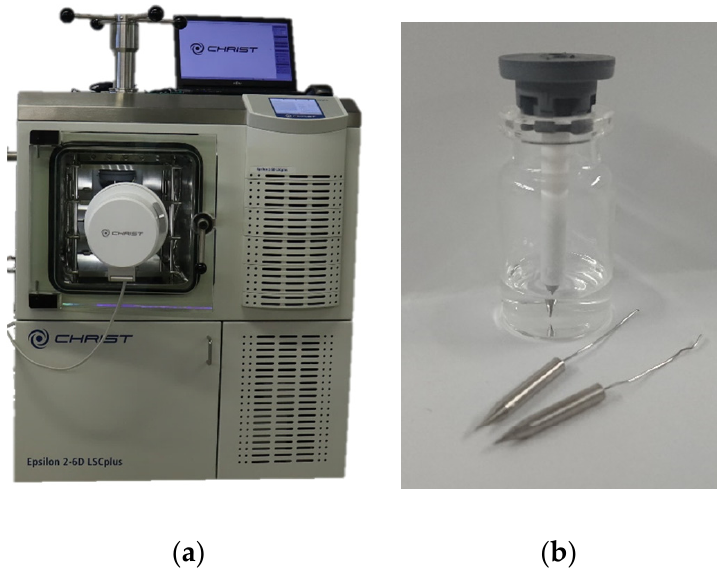
Figure 6. ( a ) Freeze-dryer Epsilon 2-6D. ( b ) WTMplus sensor [15]. Table 2. Experimental design of